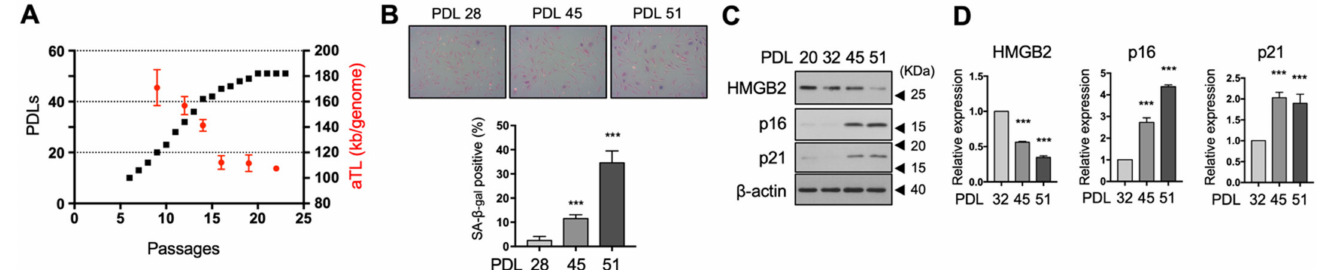
Figure 1. HMGB2 expression was decreased in replicative senescent MVECs. ( A ) The cumulative number of PDLs was calculated by counting the viable cells during subculturing and a PDL curve was generated. Telomere length per genome were also measured. ( B ) Senescence in MVECs was evaluated via SA- β -gal staining and the proportion of SA- β -gal-positive cells is shown. ( C ) HMGB2 protein levels were determined via immunoblotting analysis using MVECs showing different PDLs. The expression levels of canonical senescence markers, p16 and p21, are shown simultaneously. ( D ) The mRNA expression levels of HMGB2 , p16, and p21 were quantified via quantitative real time- polymerase chain reaction. HMGB2, high mobility group box 2; MVECs, microvascular endothelial cells; PDL, population doubling; aTL, absolute telomere length; SA- β -gal, senescence-associated beta galactosidase. *** p < 0.001.